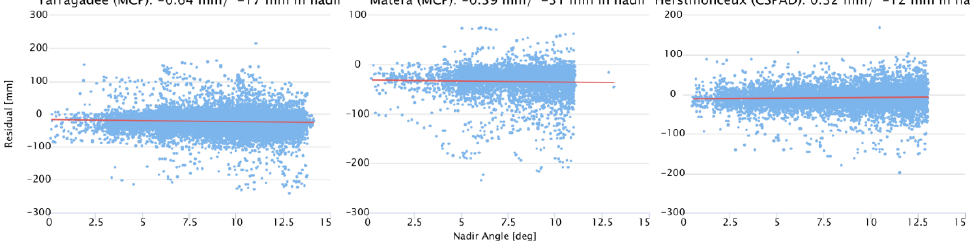
MCP, and PMT); (2) TOP10 stations; and (3) all available stations. Initially, we exclude gross outliers, which exceed 500 mm for all SLR residuals. As TOP10 we chose stations, which deliver more than 1000 normal points of stable observations, i.e., with no discontinuities in the time series in the analyzed period and did not indicate any dependencies between SLR residuals and the observational frame with respect to the azimuth and elevation angle. The list of TOP10 stations includes: Graz 7839, Herstmonceux 7840, Mount Stromlo 7825, Wettzell 7827 and 8834, Yarragadee Table 3 indicates the heterogeneity of SLR measurements to the multi-GNSS satellites, i.e., the dependency on the chosen dataset of laser stations. Mean offsets for FOC, FOC*, IOV, K1, M satellites are smaller for single-photon stations equipped with CSPAD detectors in comparison to multi-photon stations equipped with MCP or PMT detectors. For instance, the mean offset equals − 36 ± 41, − 43 ± 36, and − 44 ± 39 for Galileo FOC and − 3 ± 27, − 20 ± 20, and − 6 ± 31 for GLONASS-K1, for CSPAD, MCP, and PMT detectors, respectively.